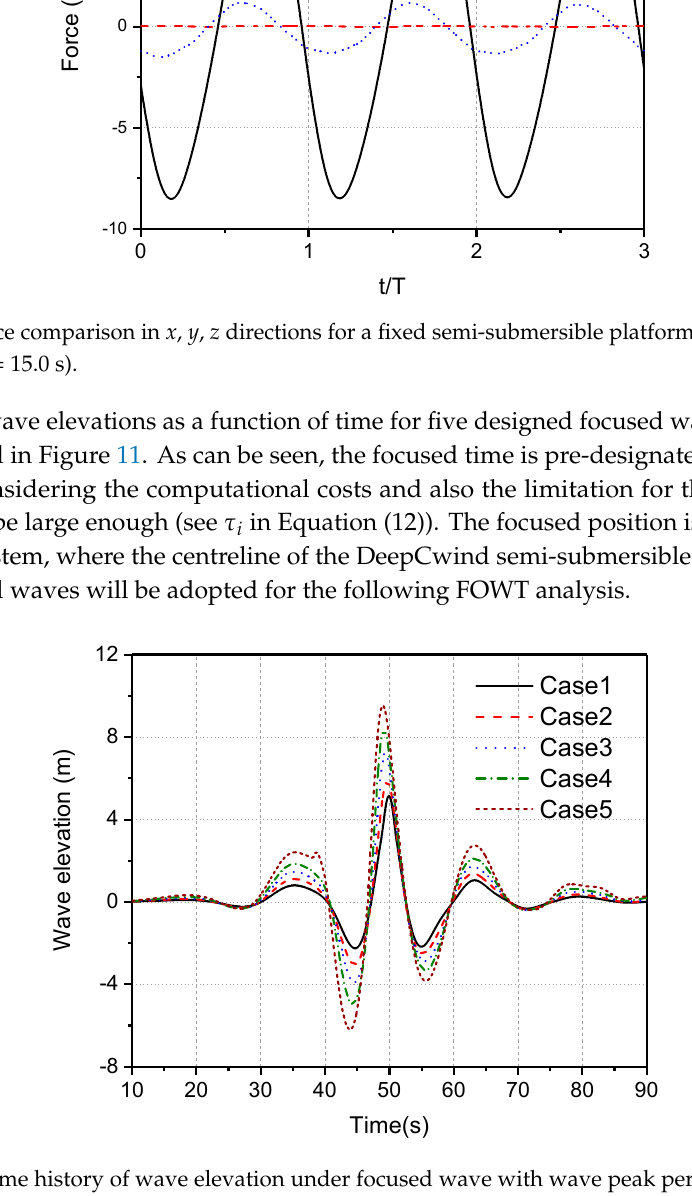
Figure 11. Time history of wave elevation under focused wave with wave peak period T p =15.0 s.